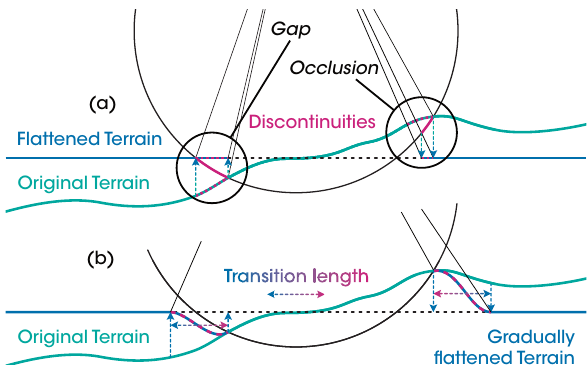
Figure 2. Inverse stereographic projection of elevation outside a sphere to its surface leading to discontinuities (a), and gradually flattening the terrain before projection to avoid them (b).